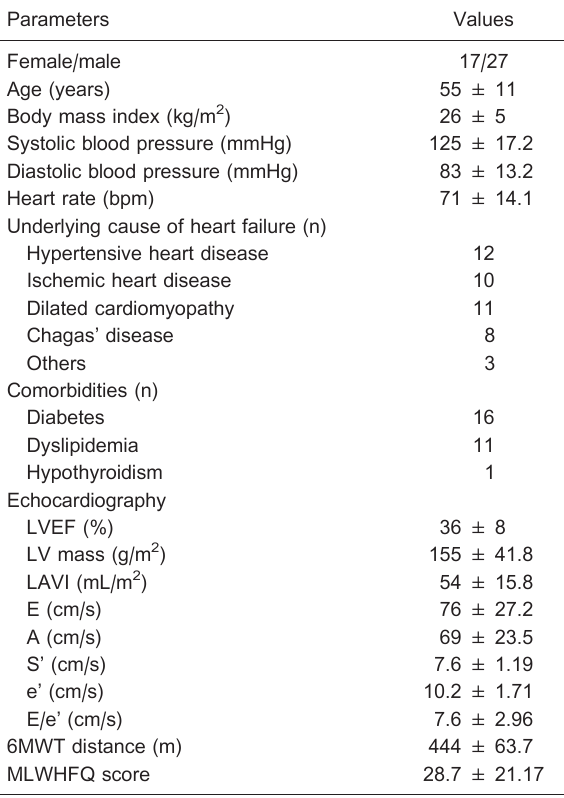
Table 1. Characteristics of the study